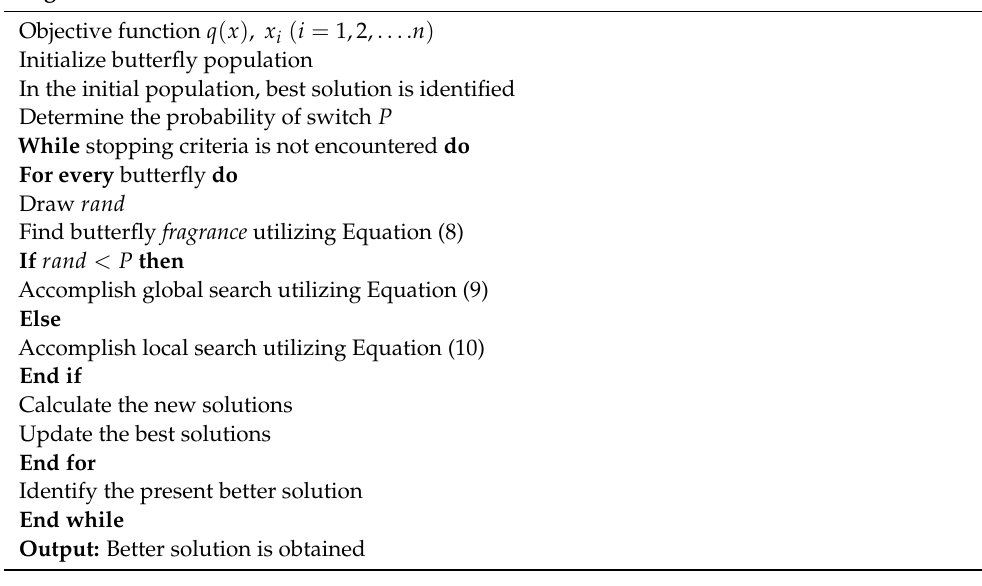
Algorithm 1 Pseudocode of BOA